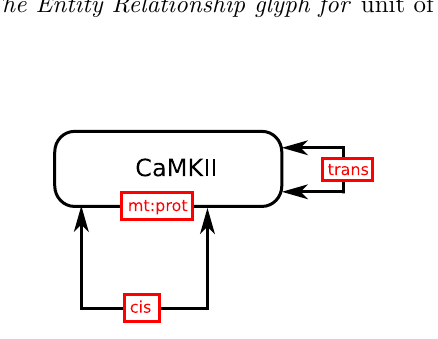
Figure 2.32: The Entity Relationship glyph for unit of information .